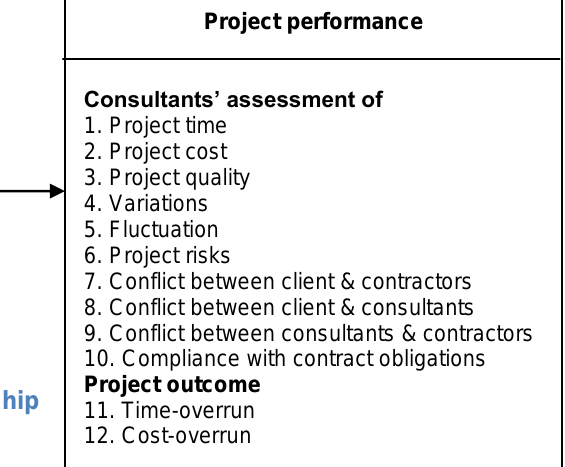
Figure 1 Framework for evaluating the relationship between the use of in-sourced and outsourced consultants and project